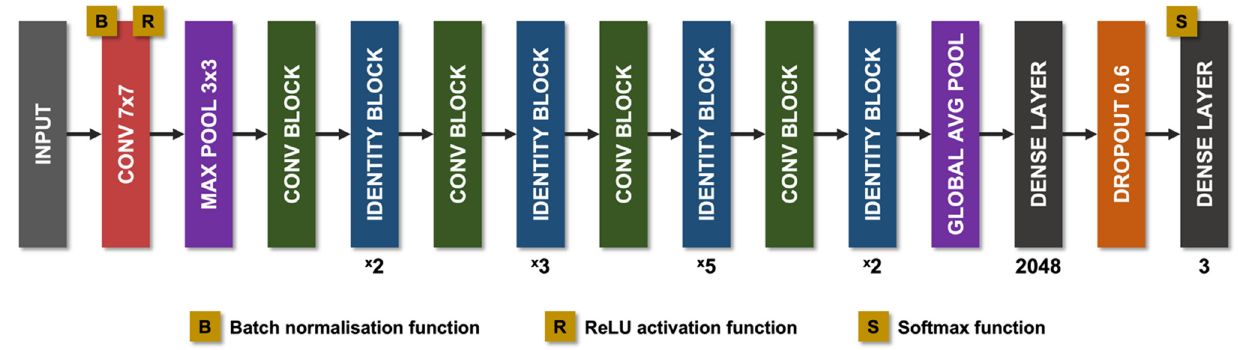
Figure 2. Diagram of the modified ResNet ‐ 50 architecture used by Preston et al. Pink rectangles correspond to convolutional layers, with the filter size given within. Purple rectangles corresponds to pooling layers, either maximum pool or global average pool. Green rectangles correspond to convolution blocks. Blue rectangles correspond to identity blocks. Dark grey rectangles correspond to dense layers. Orange rectangles correspond to dropout layers (dropout = 0.6). Avg, average; Conv, convolutional; Max, maximum; ReLU, rectified linear unit.